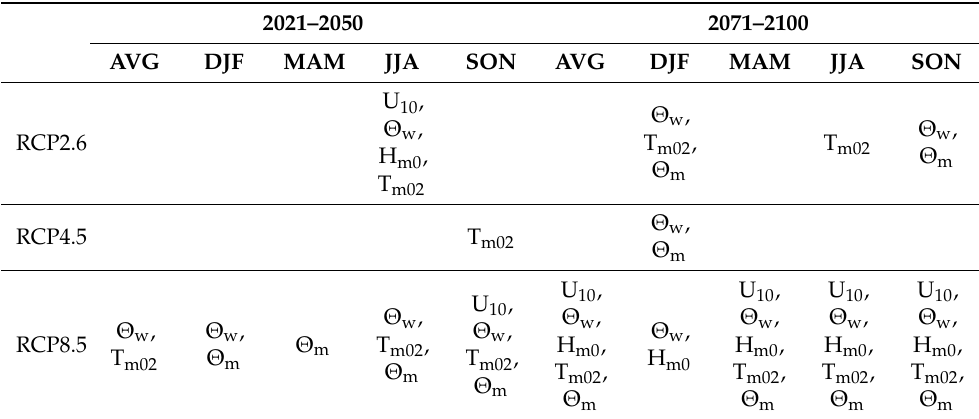
Table 2. Variables with future changes of the average wind and wave conditions (mean wind speed U 10 , wind direction Θ w , significant wave height H m0 , mean wave period T m02 and mean wave direction Θ m ) near the selected westerly wind-exposed location “Rostock-Warnemünde” for the